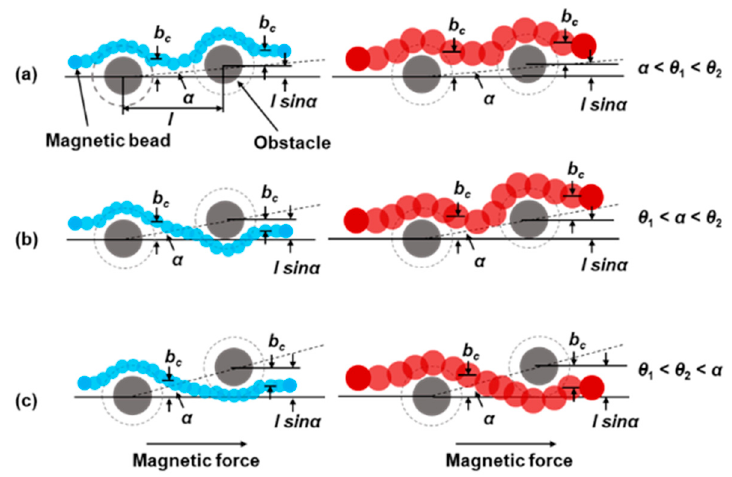
Figure 3. Schematic diagram of the trajectories of particles of two different sizes at different forcing angles. The driving angles are ( a ) α < θ 1 < θ 2 , ( b ) θ 1 < α < θ 2 and ( c ) θ 1 < θ 2 < α , respectively. We assume that the critical angle ( θ 2 ) of large particles is greater than the critical angle ( θ 1 ) of small particles. The b c and l sin α at different forcing angles were given in the schematic diagram.